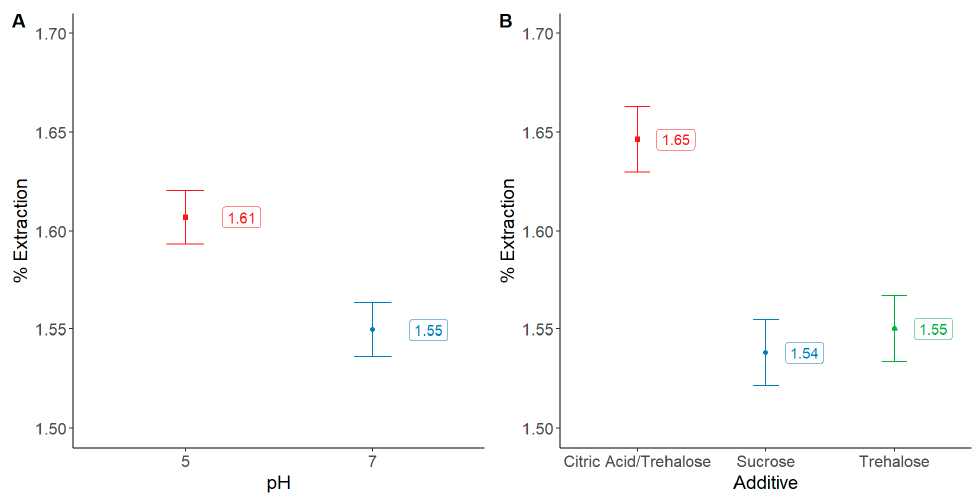
Figure 1. Comparative extraction yields of phycocyanin (%) as a function of ( A ) pH and ( B ) additives. Bars show means and least significant difference intervals for 95% confidence; non overlapped bars are statistically different among them.